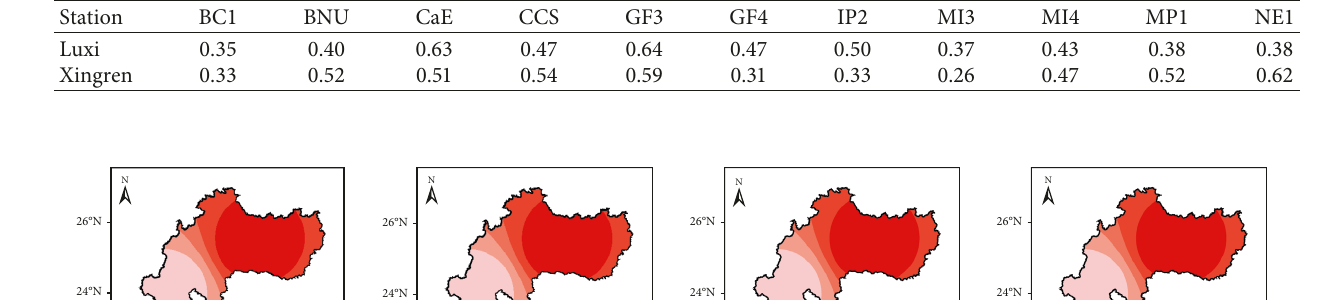
Table 7: Results of the composite rating metrics of each climate